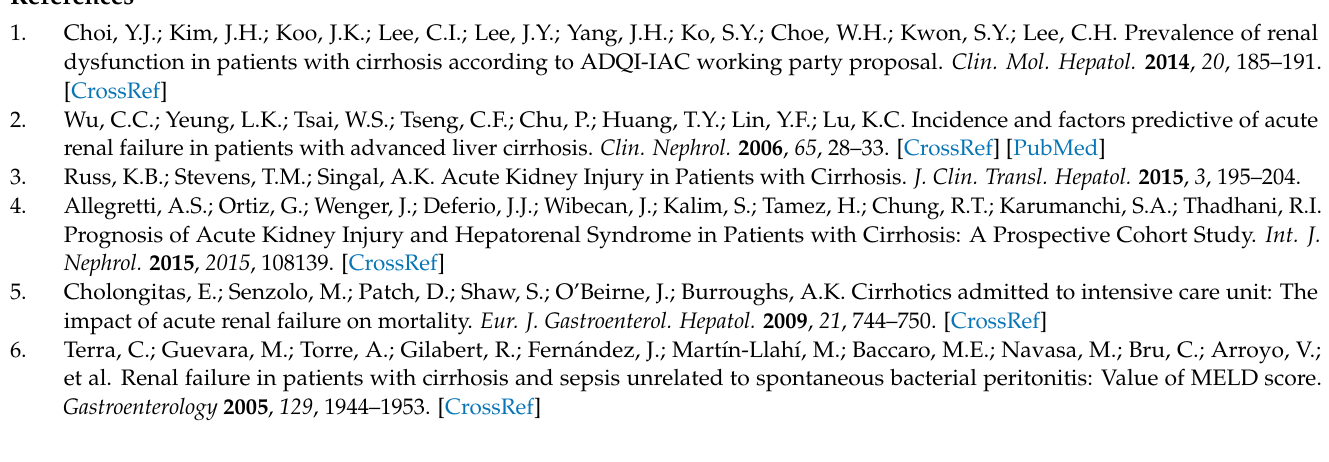
admission; Table S2: Variables associated with the development of HRS in cirrhotic patients admitted with Acute Kidney Injury stratified by the presence of chronic kidney